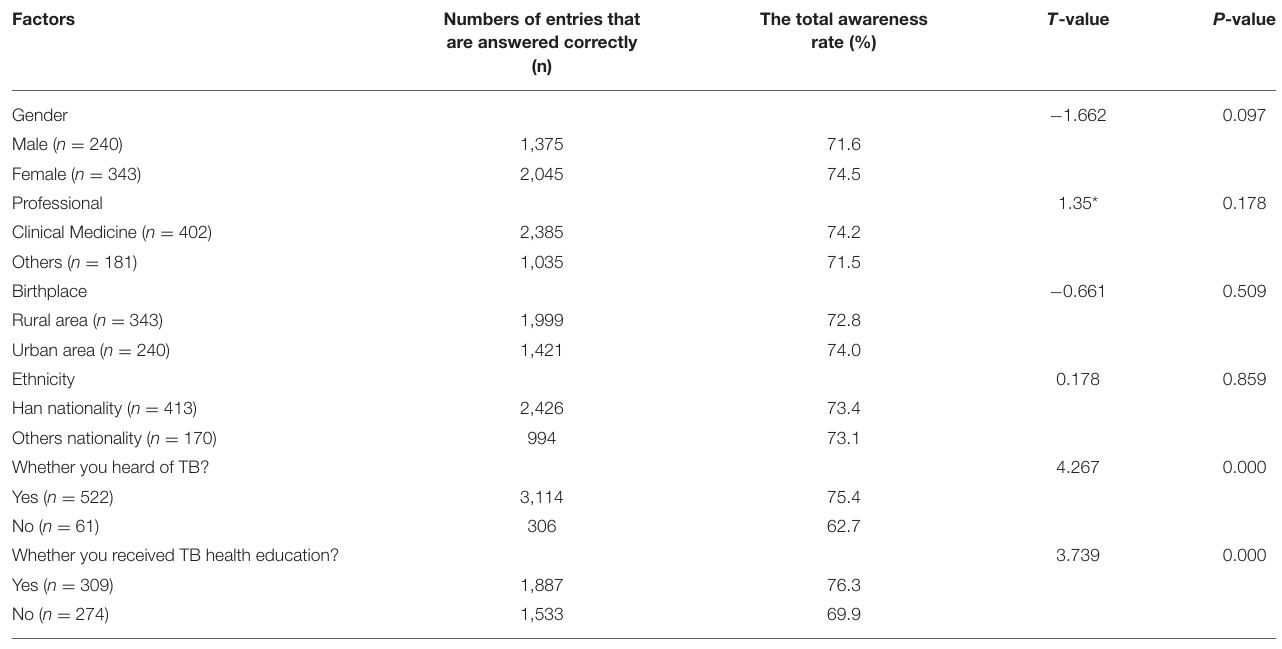
The total awareness are answered correctly rate (%) (n)